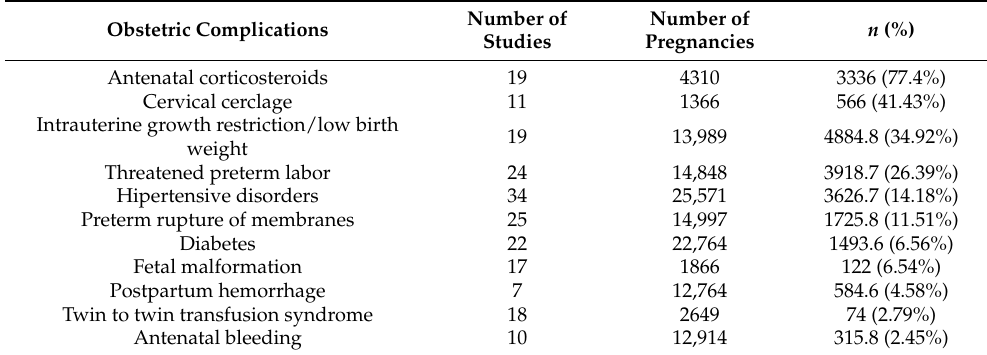
Table 3. Obstetric complications in the triplet pregnancies included in the systematic